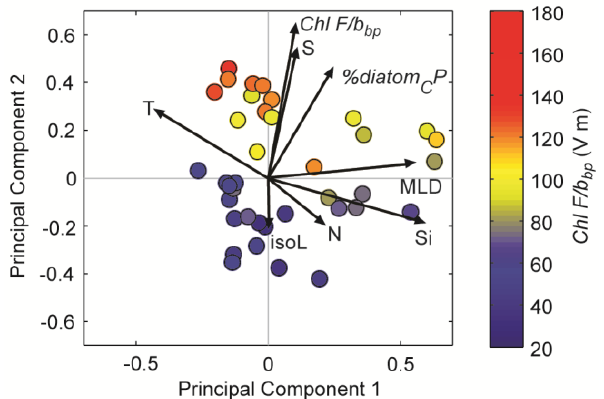
Figure 7. PCA biplot for R/V Knorr CTD stations ( n = 38), color- coded according to median Chl F/b bp for 10–50m, where blue corresponds to Group 1, yellow to Group 2 and red to Group 3. Together, principal components (PCs) 1 and 2 explain 68.7% of the variance. The length of a single parameter vector (black line with arrow) describes its contribution to the PC, while the direction of the vector, starting from the axes intersection, depicts the “biplot” gradient of the specific parameters: T – temperature; S – salinity; IsoL – 0.415 isolume depth; MLD – mixed-layer depth; N – ni- trate; Si – silicic acid; Chl F/b bp – optical community index; and % diatom C P (here representing % diatom C product for brevity).